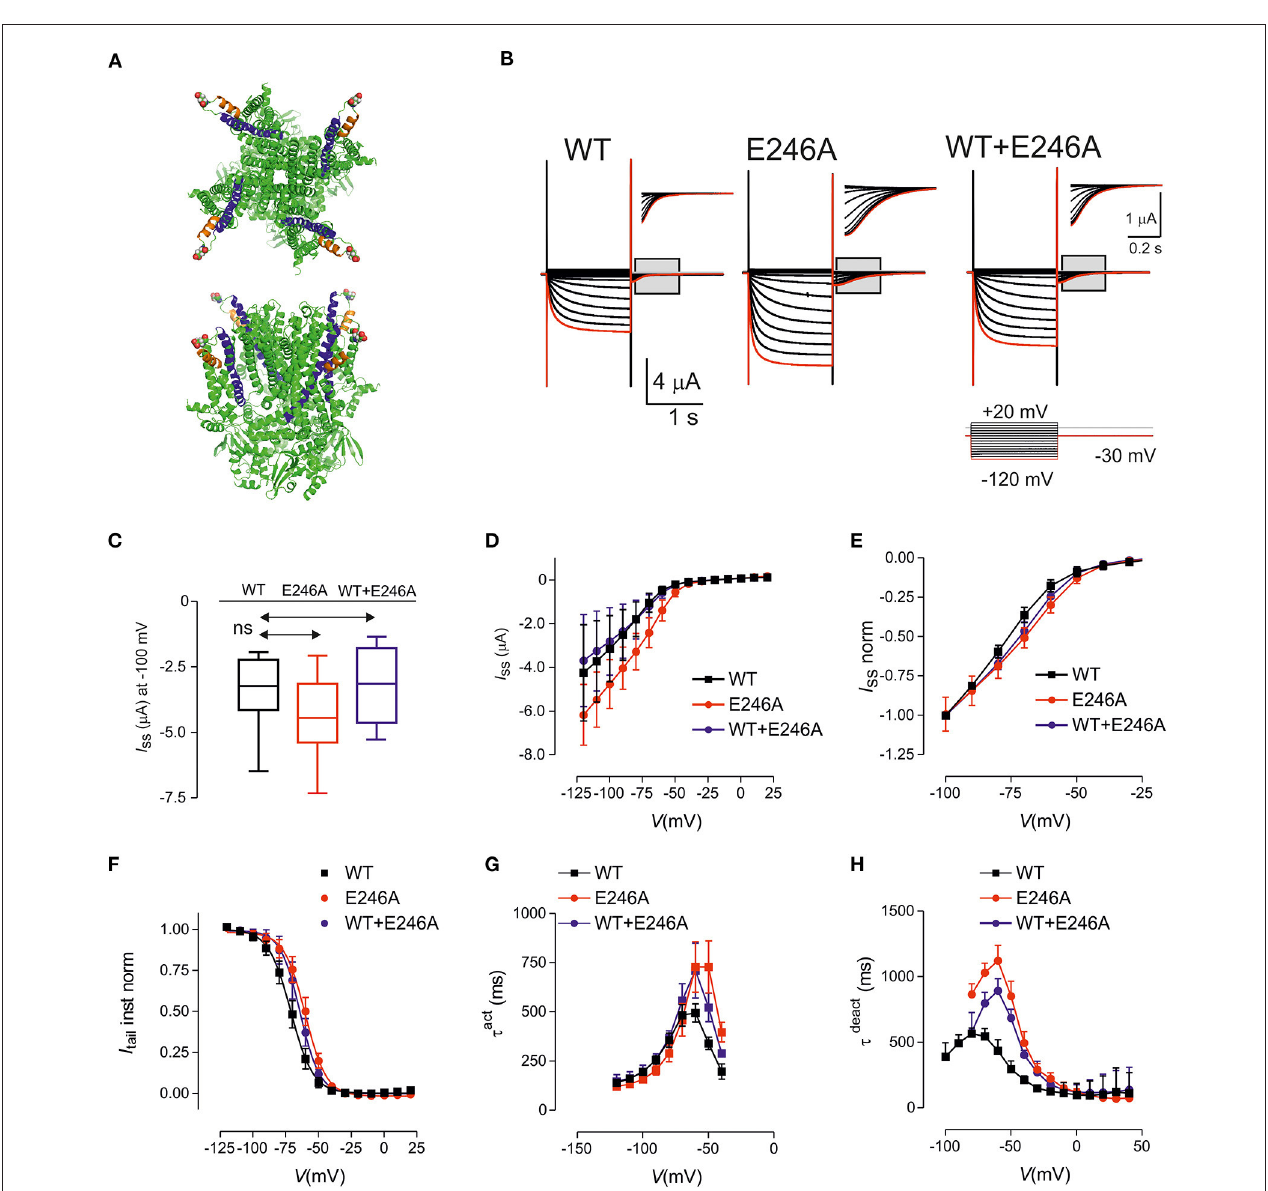
FIGURE 1 | HCN1 E246A variant causes changes in the biophysical properties consistent with gain of function. (A) Structure of human HCN1 showing location of E246 (shown as spheres). Based on PDB 5u60 for human HCN1 in the depolarized (closed) conformation, rendered using PyMOL (The PyMOL Molecular Graphics System, Version 2.3.4 Schrodinger, LLC.). Upper panel: view from external medium; lower panel: side view. (B) Representative voltage clamp data from oocytes expressing HCN1 wild-type (WT) (left); E246A (middle) and co-expressed WT + E246A (right). Each dataset shows current traces in response to a series of voltage steps (inset) from the holding potential ( − 30mV) to test potentials in the range − 120 to + 20mV (activation protocol, see Methods). Gray boxed areas have been enlarged to show tail currents. Note the different scales. Red trace corresponds to voltage step at − 120mV. (C) Box and Whisker plot of maximal steady-state current for HCN1 WT ( n = 9); E246A ( n = 9),and WT + E246A ( n = 9) measured at end of test pulse to − 100mV; ns, not significant. (D) Pooled current-voltage (I–V) data shows a shift in the voltage-dependence of steady state activation for “homozygous” ( n = 9 each group) compared to WT ( n = 9). (E) Normalized, pooled I-V data reveals the right shift in steady-state activation; each data set was normalized to the steady-state current at − 100mV. The “heterozygous” data lies between the “homozygous” and WT data sets ( n = 9 for each data set). (F) Normalized, instantaneous tail currents fit with a single Boltzmann function. Fit values were: V 0.5 − 71.1 ± 0.4mV (WT); − 60.1 ± 0.4mV (E246A); − 64.1 ± 0.4mV (WT + E246A) and z: 2.92 ± 0.11 (WT); 3.09 ± 0.12 (E246A); 3.34 ± 0.15 (WT + E246A). (G) Mean activation time constant τ act obtained by fitting the time-dependent component of activating current with a single exponential function (see Methods). (H) Mean deactivation time constant obtained by fitting the time-dependent component of deactivating current with a single exponential function. Data points were joined for visualization. Data are expressed as mean ± s.d; statistical comparisons were made to wild-type using one-way ANOVA with Dunnett’s post-hoc test (see Supplementary Tables 1–3 for detailed